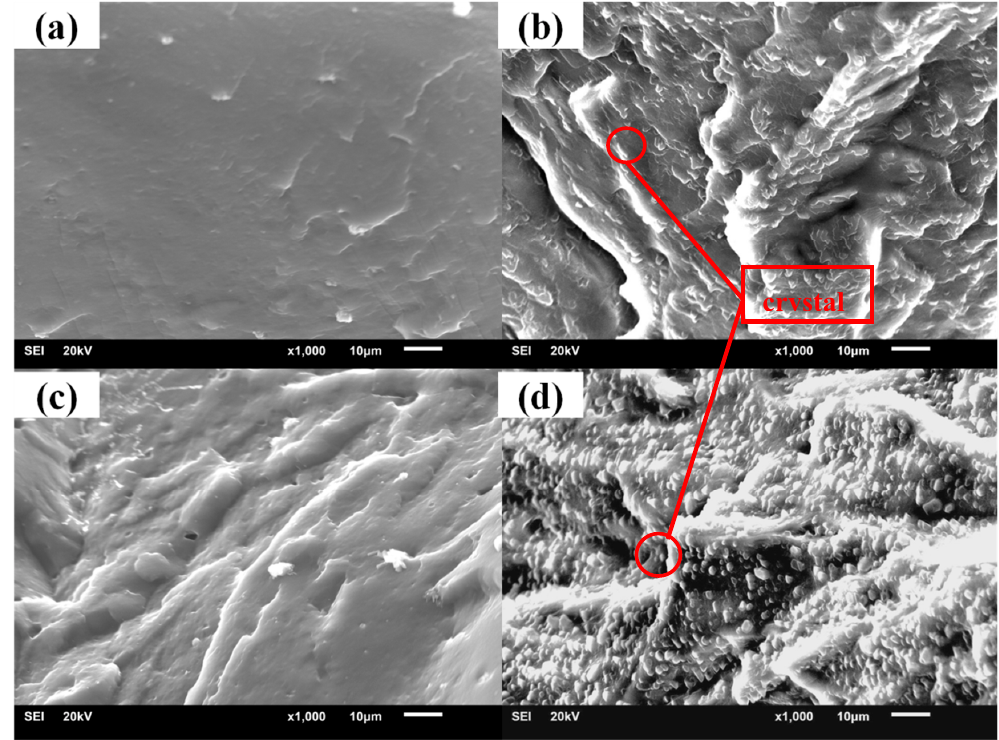
Figure 7. SEM patterns of XNBR/AO-2246 before and after thermal aging: ( a ) XNBR/AO-2246(10); ( b ) XNBR/AO-2246(10) after aging; ( c ) XNBR/AO-2246(50); ( d ) XNBR/AO-2246(50) after aging.